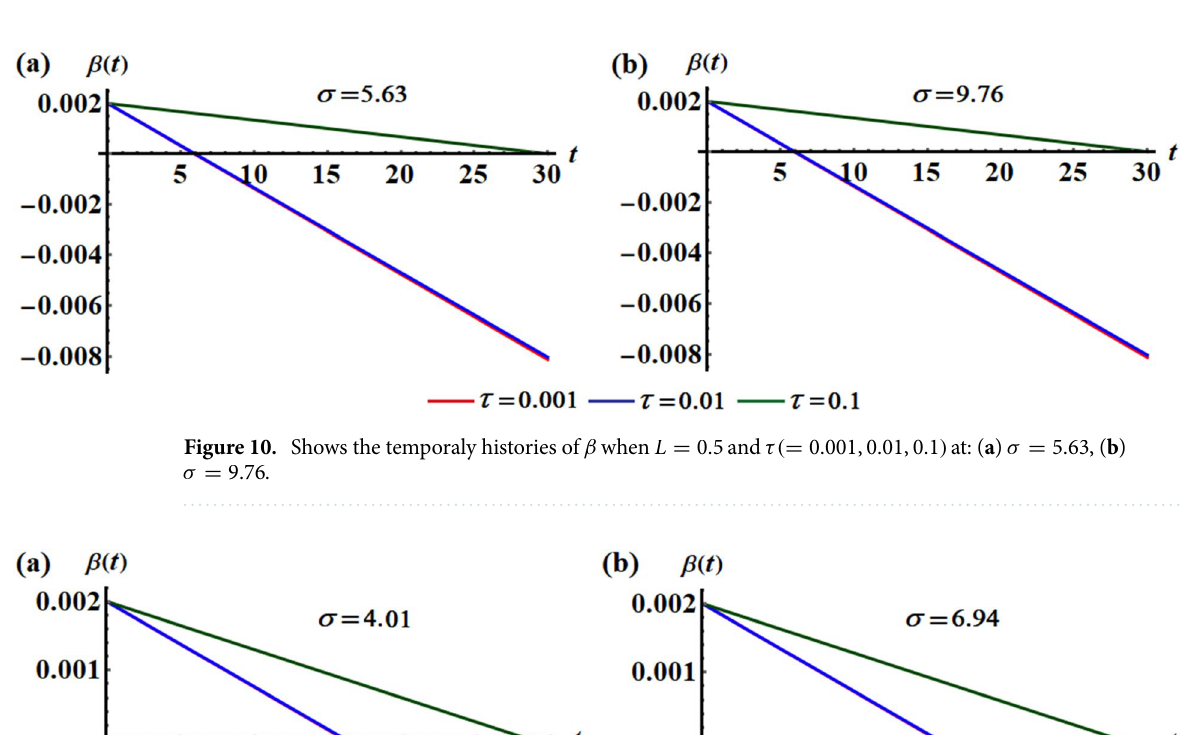
Figure 9. Reveals the curves of Fig. 8 in the plane θ ˙ θ .